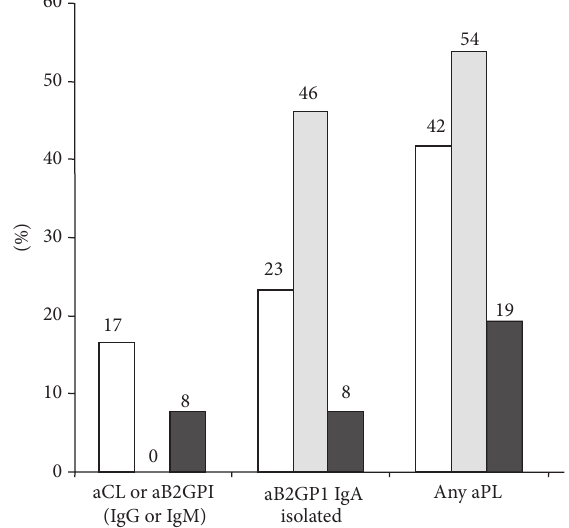
Figure 4: Percentage of APS patients positive for aPL antibodies. APS patients were classified as follows: venous thrombosis (white), arterial thrombosis (grey), and pregnancy morbidity